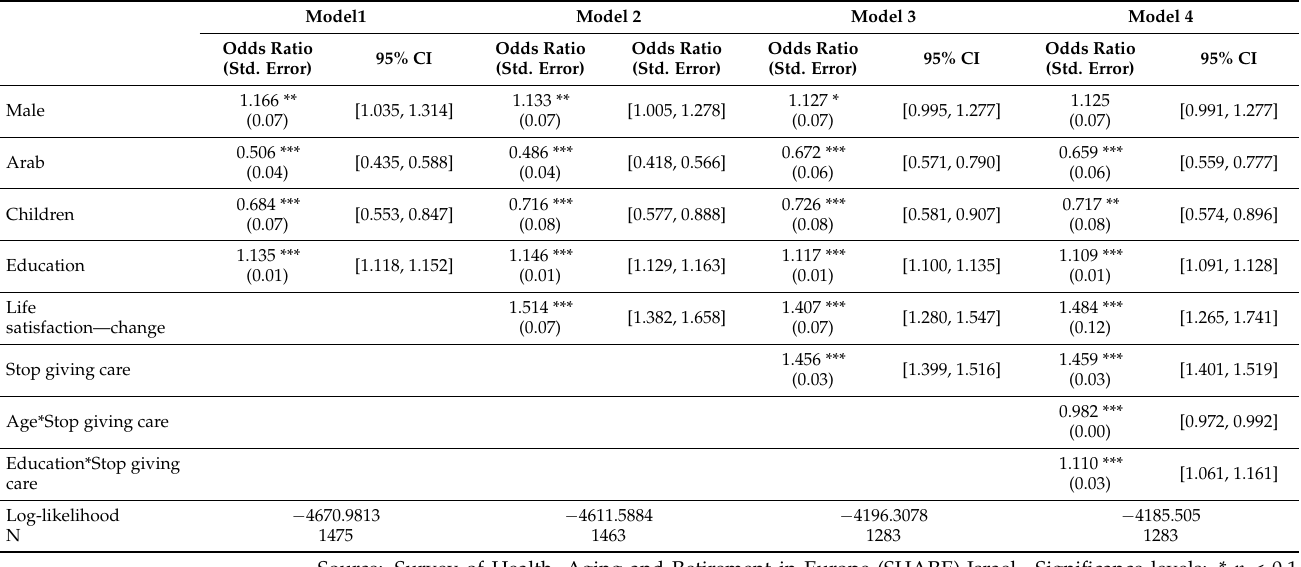
Table 4. Ordered logistic regression analysis with ‘make ends meet’ as dependent variable (odds ratio).